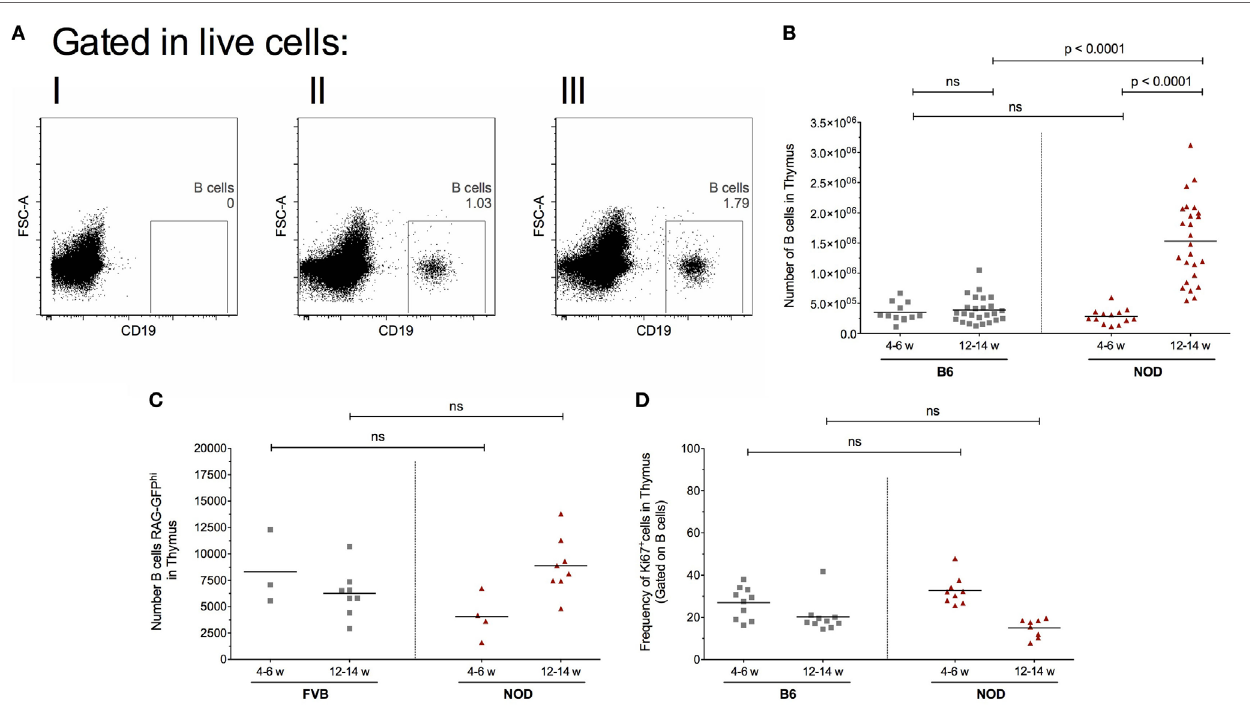
FigUre 1 | Intrathymic B cell accumulation precedes β cell destruction. Single-cell suspensions were prepared from the respective thymi and all data analyzed on a single cell, live gate. (a) Representative dot plots of thymic CD19 + cells: (I) isotype control for CD19 antibody; (II) 12-week-old female B6 mouse; and (III) 12-week-old female non-obese diabetic (NOD) mouse. (B) Number of B cells in the thymus of 4- to 6-week-old female B6 mice ( n = 11), 12- to 14-week-old female B6 mice ( n = 25), 4- to 6-week-old female NOD mice ( n = 13), and 12- to 14-week-old female NOD mice ( n = 25). (c) Number of RAG-GFP hi B cells in the thymus of 4- to 6-week-old female FVB-RAG-GFP mice ( n = 3), 12- to 14-week-old female FVB-RAG-GFP mice ( n = 8), 4- to 6-week-old female NOD-RAG-GFP mice ( n = 4), and 12- to 14-week-old female NOD ( n = 8). (D) Frequency of Ki67 + B cells in the thymus of 4- to 6-week-old female B6 mice ( n = 10), 12- to 14-week-old female B6 mice ( n = 10), 4- to 6-week-old female NOD ( n = 9), and 12- to 14-week-old female NOD mice ( n = 8). Data presented as scatter plot, each dot equating to a mouse, the bar representing the mean value. Statistical significance determined using the non-parametric Mann–Whitney U -test, significant P values are shown; ns, not